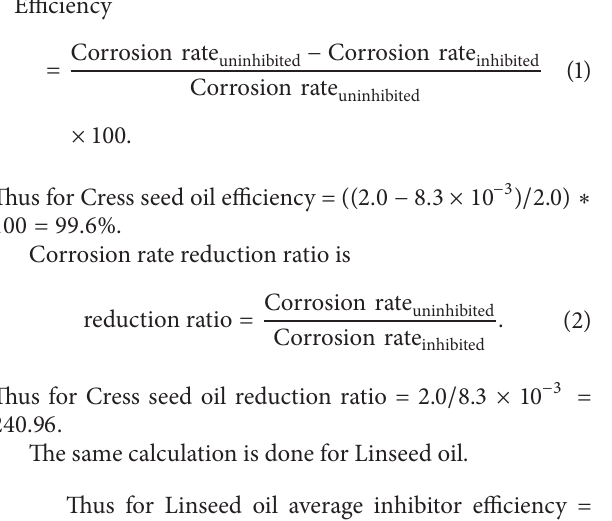
Figure 2: (a) Corrosion rate versus time by linear polarization measurements for uninhibited carbon steel coupon in stirred aerated seawater. (b) Corrosion rate versus time by linear polarization measurements for inhibited carbon steel coupon in stirred aerated seawater. Cress seed oil derived inhibitor at 1000ppm concentration